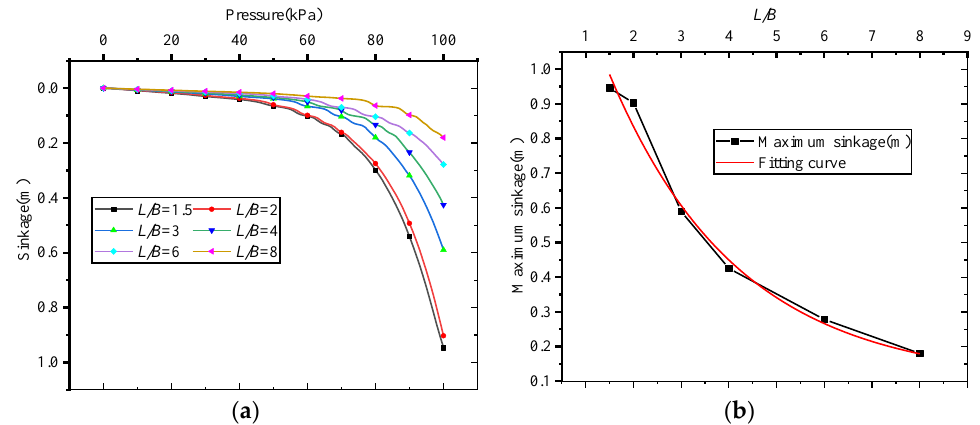
Figure 17. ( a ) Pressure-sinkage curves and ( b ) maximum sinkage under different conditions at 100